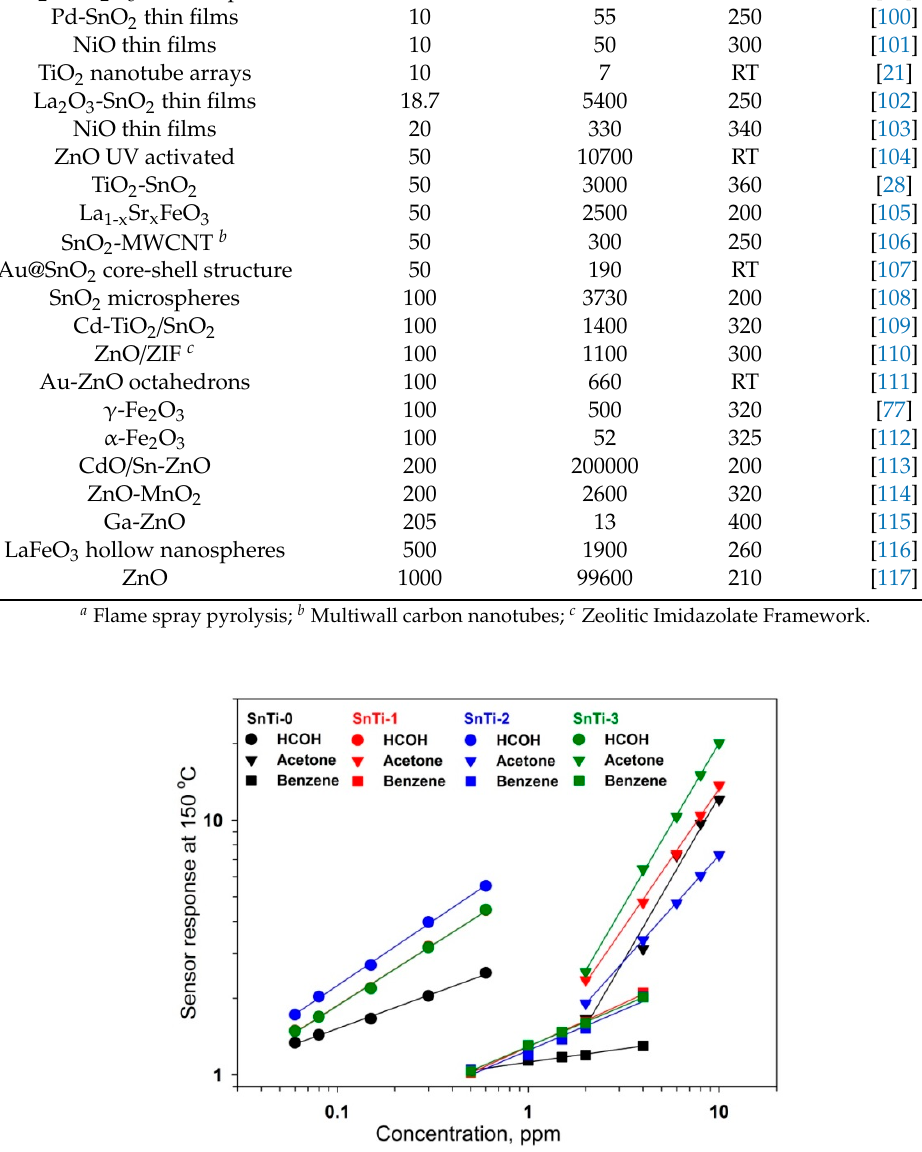
Figure 14. Cross sensitivity of SnO 2 (SnTi-0, black), SnTi-1 (red), SnTi-2 (blue) and SnTi-3 (green) nanocomposites toward HCHO (circles), benzene (squares) and acetone (triangles) at 150 °C.